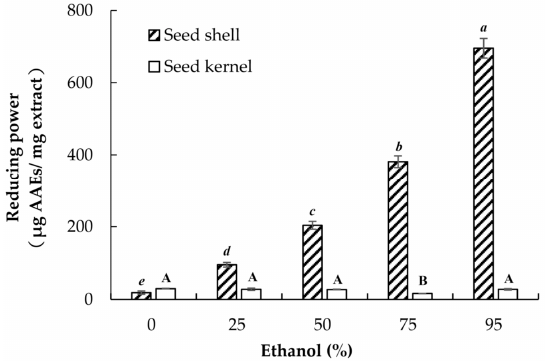
Figure 4. Reducing power of the seed shell and kernel extracts obtained using ethanol solutions of different concentrations. Mean within the seed shell (in small letter) and within the seed kernel (in capital letter) followed by the same letter(s) are not significantly different at the 5% level by Tukey test.